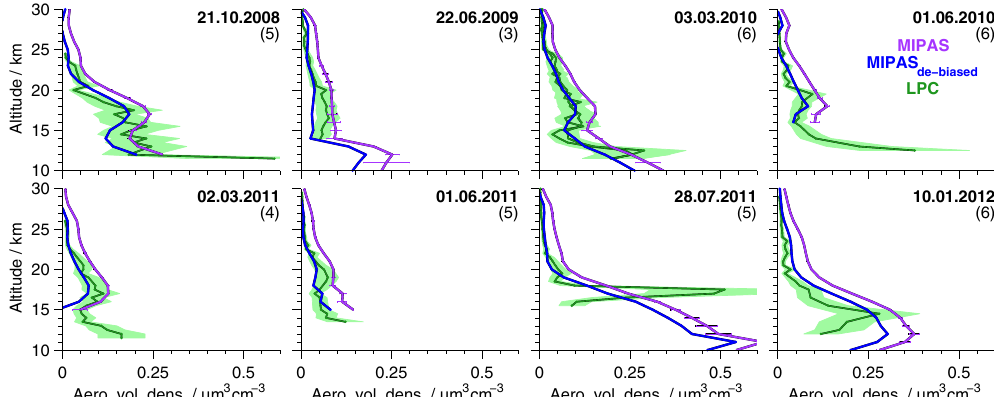
Figure 3. Profiles of aerosol volume densities from in situ and MIPAS satellite measurements. In situ data are balloon-borne data above the lapse rate tropopause for Laramie, Wyoming (41 ◦ N, 105 ◦ W), measured by laser particle counters. Two instruments were flown on the 3 March 2010. The 40% errors of the in situ data are shown as green shaded areas. MIPAS satellite data are shown in purple (original data) and blue (de-biased data). On all MIPAS data the ice filter by Griessbach et al. (2016) and ash filter by Griessbach et al. (2014) and our PSC filter have been applied. MIPAS profiles are averages of all available profiles for the indicated day, averaged in a ± 5 ◦ lat × 10 ◦ long area. The number of MIPAS profiles included in the average is given in brackets. The 1 σ standard errors of the mean profiles are shown for the non-de-biased MIPAS